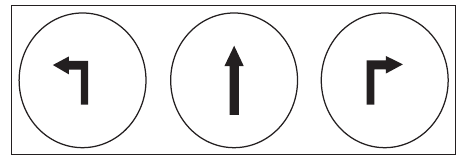
Figure 1: Each traffic light includes 3 lights with the capacity of sending 27 kinds of traffic light